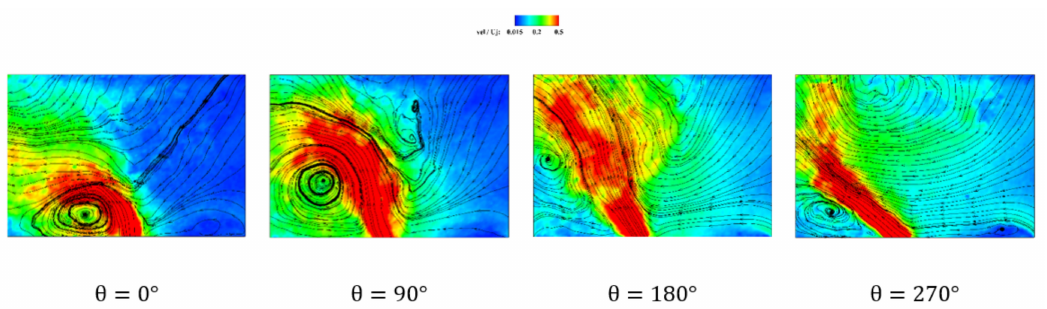
Figure 19. Phase identification for the free external domain at Re = 6440.